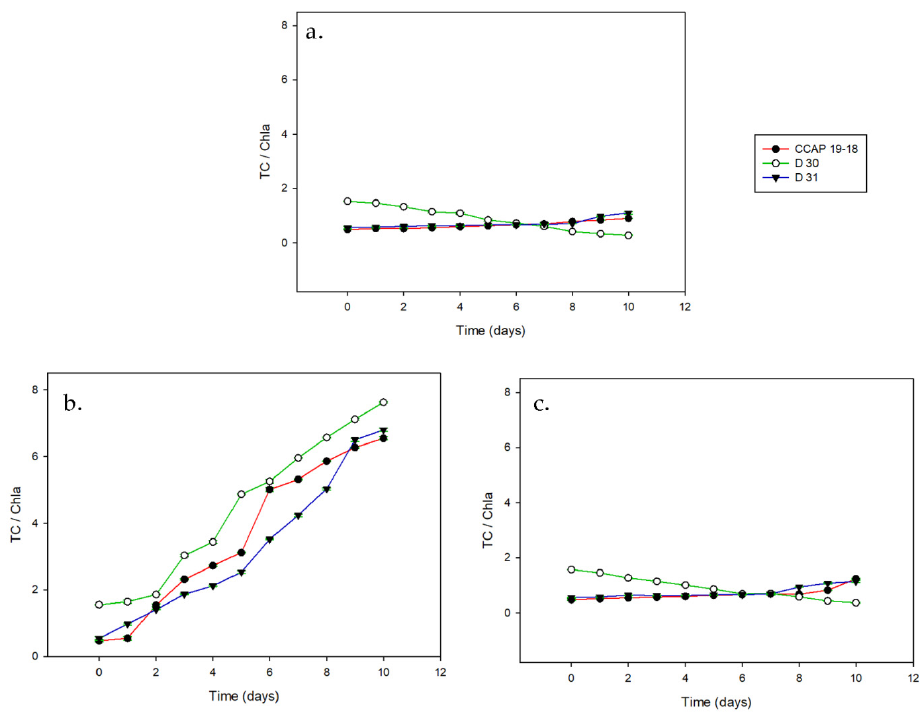
Figure 4. Daily changes in the total carotenoids to chlorophyll-a ratio (TC/Chl a ) of the studied strains cultivated in different conditions: ( a ) standard conditions, ( b ) nitrogen deprivation and ( c ) salinity stress (SE, n = 3).